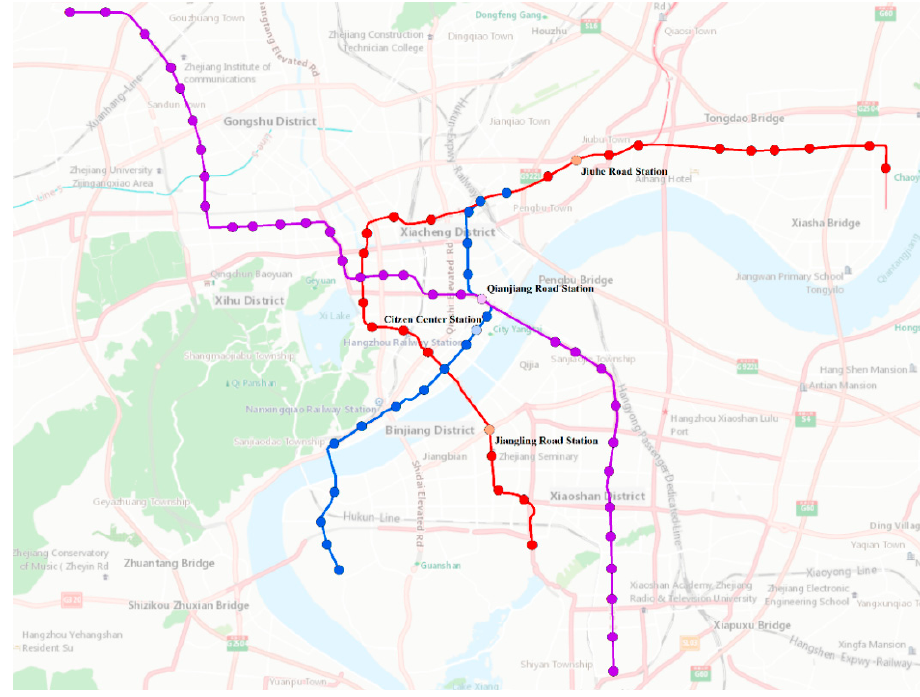
Figure 7. Selected metro stations.